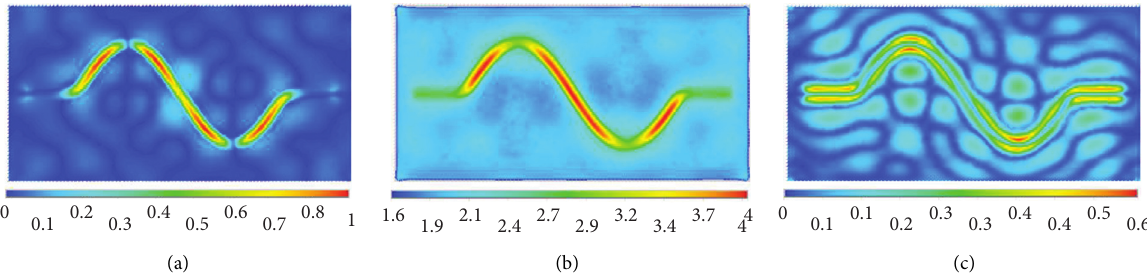
Figure 15: SH wave incident ( f � 1.5Hz, H � 100m, C